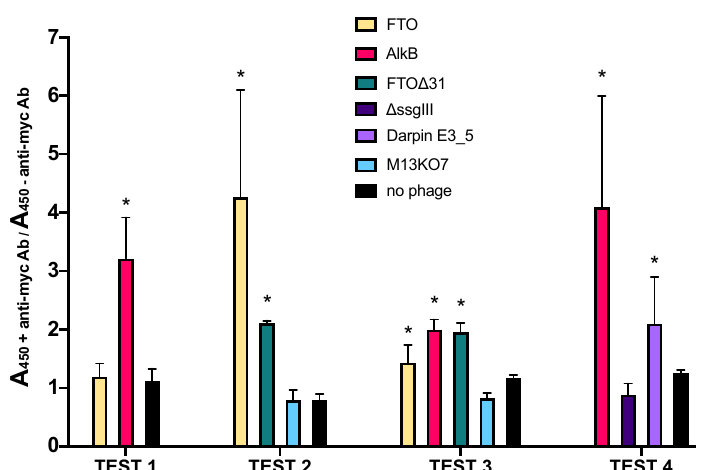
Figure 1. Assessment of effective display by phage ELISA. Display of target protein was measured indirectly by detection of the fused c-myc tag with anti-c-myc antibody. Bars represent absorbance ratios determined in presence (+Ab) and absence (-Ab) of immobilized anti-c-myc antibody. Since not all tests featured the same experimental variables (e.g., sample prep, age), data from different tests are shown separately. Ratios within each test are the mean of at least six technical replicates. Asterisks (*) indicate that the ratio of a particular sample within one test is significantly higher ( p -value < 0.05) compared to the no-phage control.